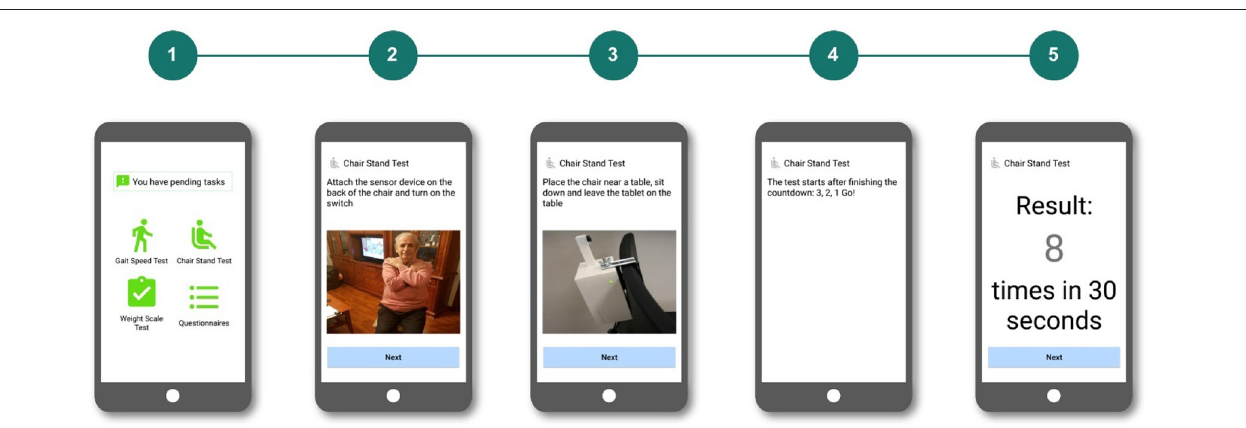
FIGURE 8 | Chair stand test interaction flow used in the second test, where the user only had one navigation